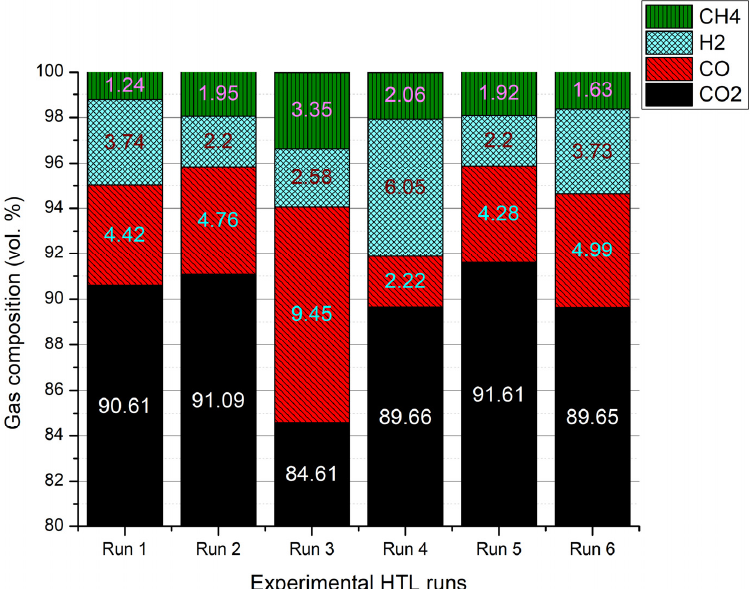
Figure 6. Comparative overview of the compositional profiles of the HTL by-product gases across the experimental range.